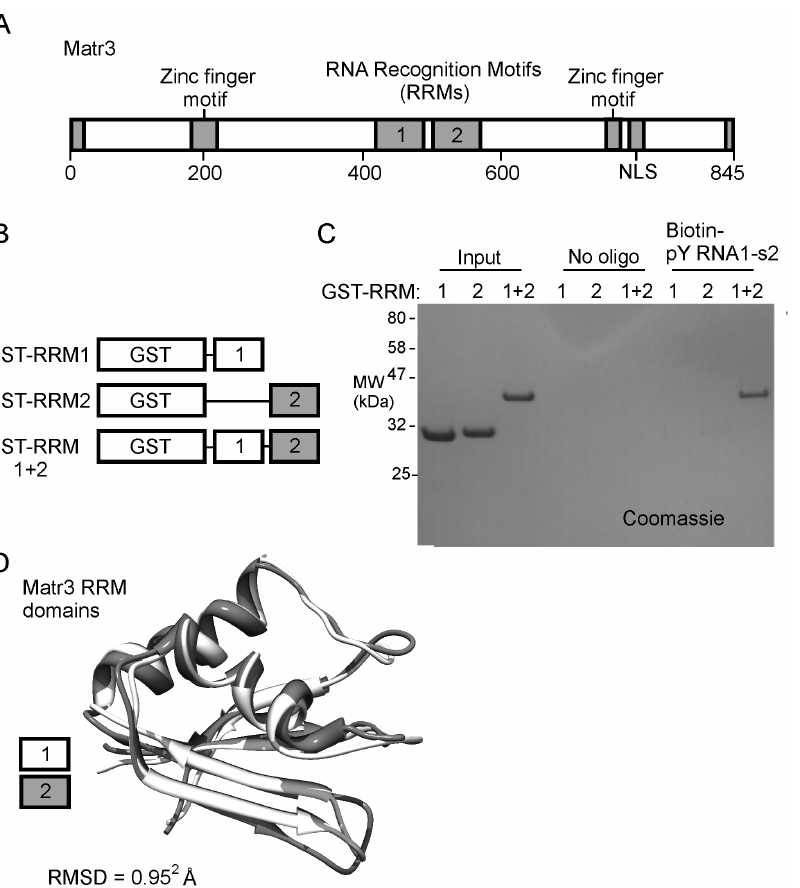
Figure 8. Both RRM domains of Matr3 are required for the interaction with pY RNA1-s2. A. Schematic of Matr3 indicating the Zinc finger binding domains and the RNA Recognition Motifs (RRMs) from within Matr3. B. Schematic of constructs created as N-terminal Glutathione S- transferase (GST) fusion proteins with the RRM from Matr3, used in this binding study. C. Immobilized pY RNA1-s2 was incubated with the indicated GST-RRM proteins and SDS-PAGE followed by Coomassie blue staining; this demonstrates that RRM1 + 2, but not RRM1 or RRM2 alone bind to pY RNA1-s2. ‘‘Input’’ lanes represent the total amount of each protein (2 m g) that was incubated with either beads alone (no oligo lanes) or with 100 pmols of pY RNA1-s2-biotin pre-coupled to streptavidin M280 beads (Biotin-pY RNA1-s2 lanes). D. Alignment of crystal structures of the Matr3 RRM domains (PDB ID: 1WEX and 1X4F) obtained from the RCSB database [39] reveal an RMSD of 1.03 A˚.